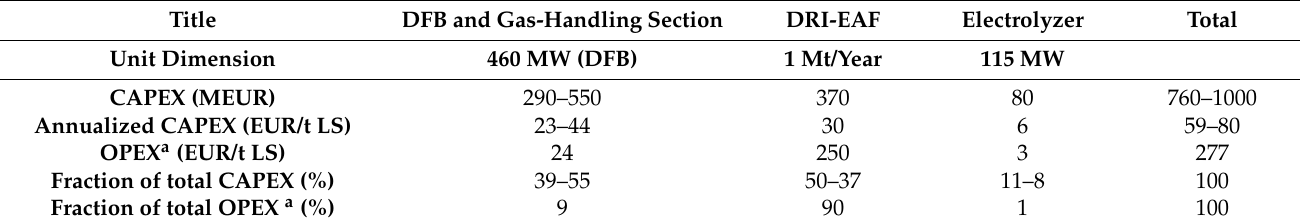
Table 9. CAPEX and OPEX for the DFB unit and gas-handling section, the DRI-EAF section, and the electrolysis section, for a plant that produces 1 Mt steel per year. The OPEX does not include the costs for biomass and electricity, nor does it account for revenues associated with negative CO 2 emissions. However, it accounts for the cost of the iron pellets.